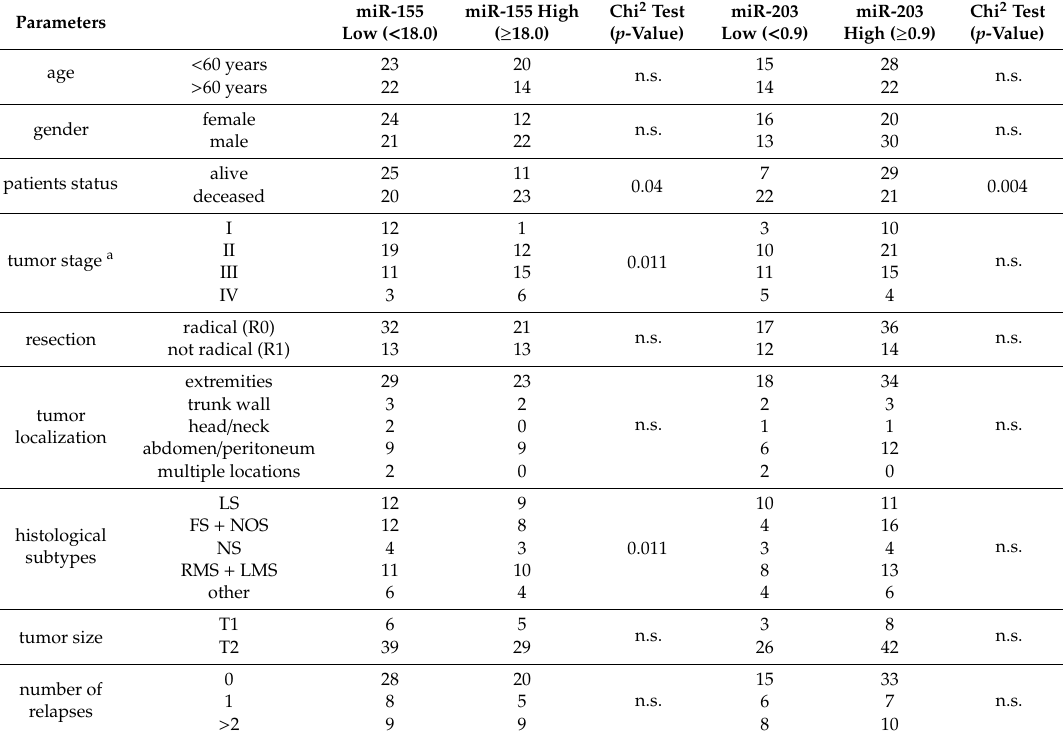
Table 3. MiR-155 and miR-203 expression in relation to clinical and histopathological characteristics in soft tissue sarcoma